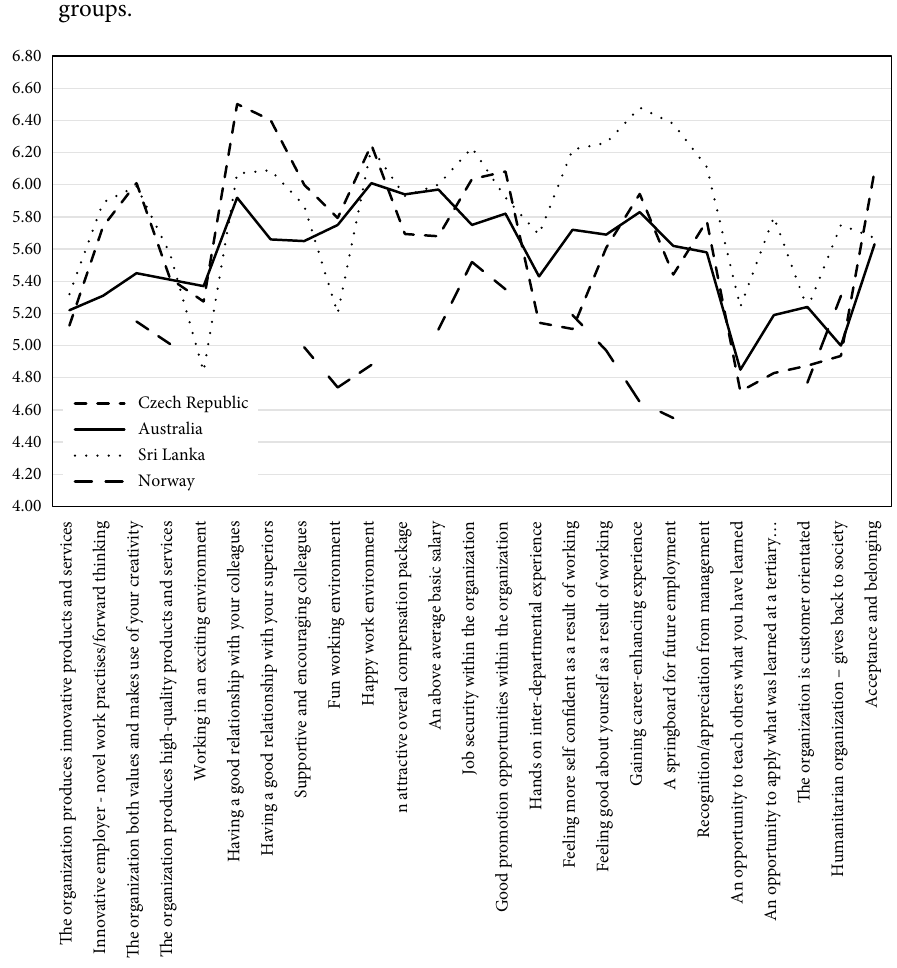
Figure 2. Differences in mean scores of employer attractiveness by nationality (source: own, 2018) Note: Research from Norway by Sivertzen et al. (2013) did not contain all the items from the study by Berthon et al.